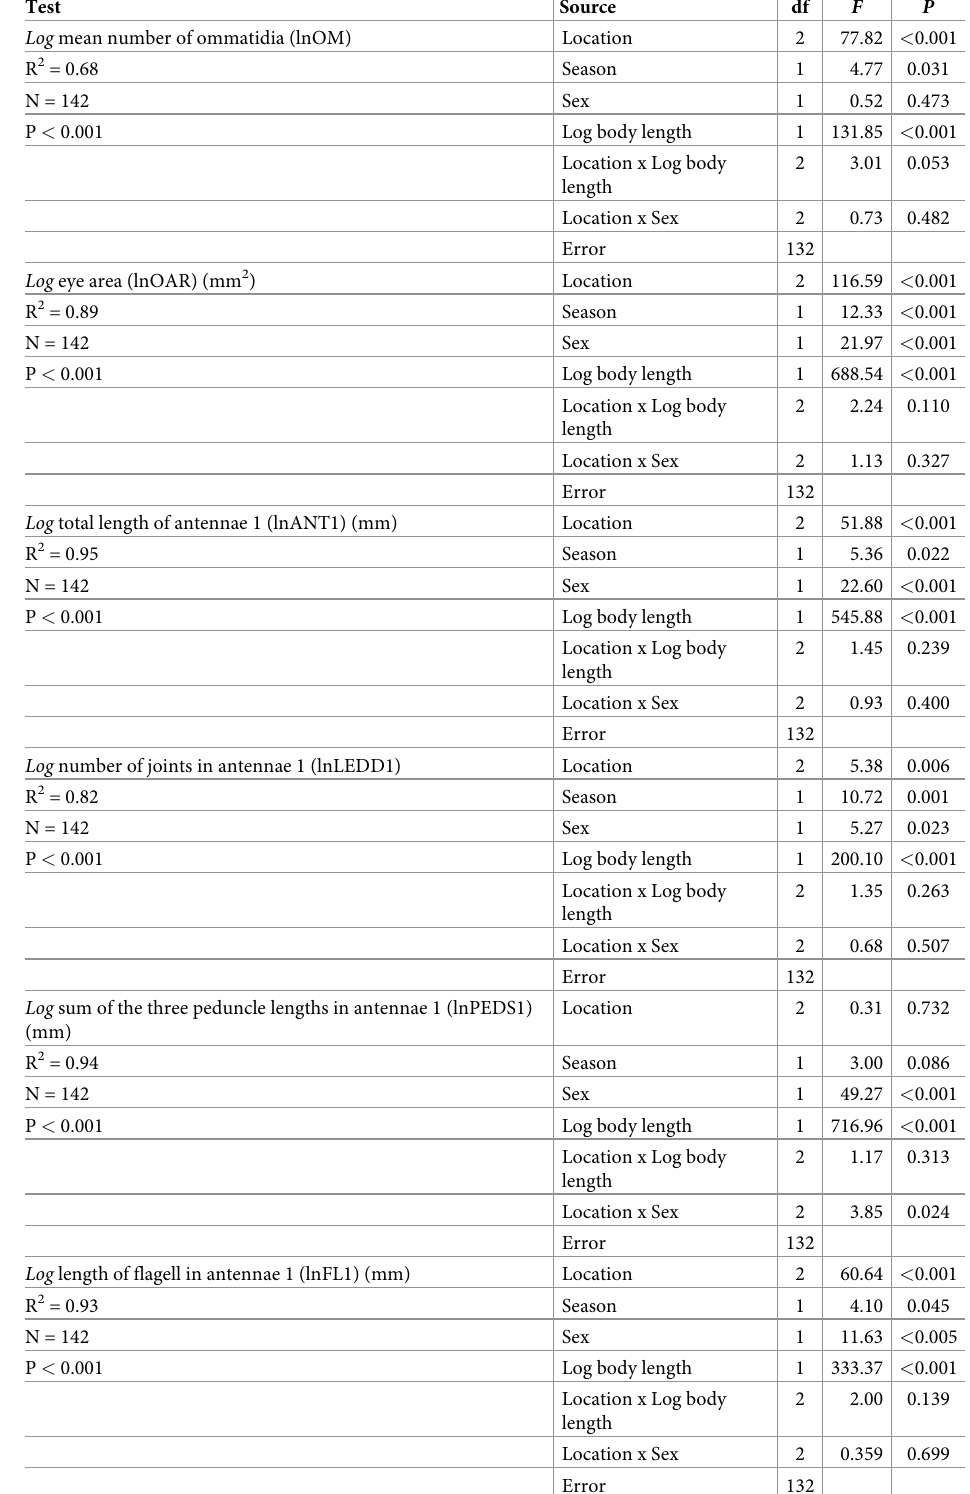
Table 4. Results for morphometric trait